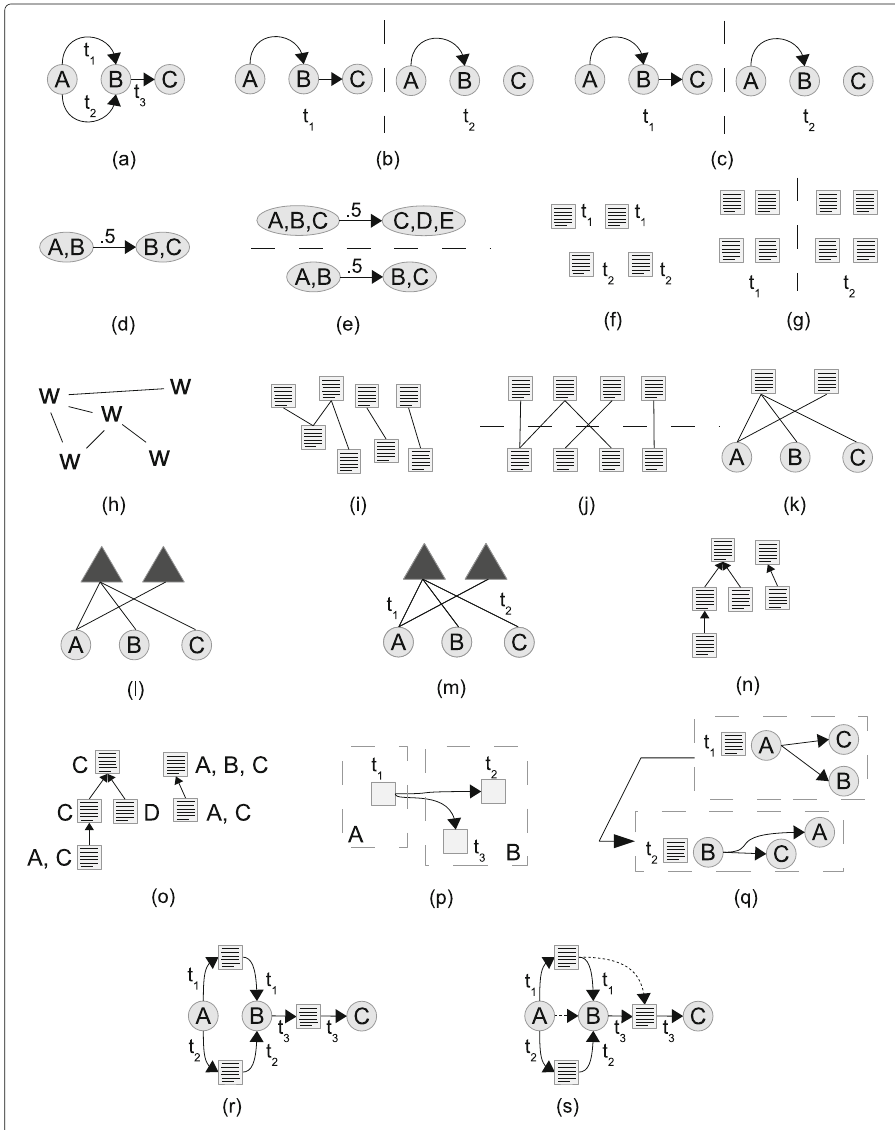
Fig. 2 A visual gallery of models for time text and networks. a ) contact sequence b ) time slices ( t 1 and t 2 adjacent) c ) longitudinal network d ) memory network e ) multi-layer memory network f ) temporal text g ) longitudinal text h ) language network i ) document network j ) doc-phrase graph k ) HIN l ) socio-semantic network m ) temp. socio-semantic network n ) citation network o ) author-citation network p )